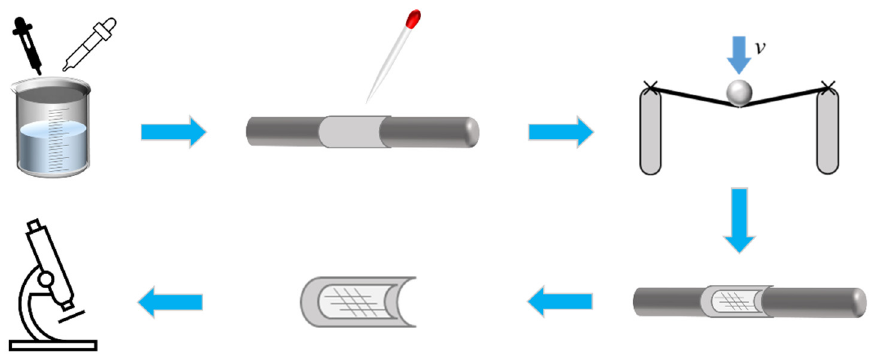
Figure 2. Experimental method for extracting realistic contact surface of the yarn.